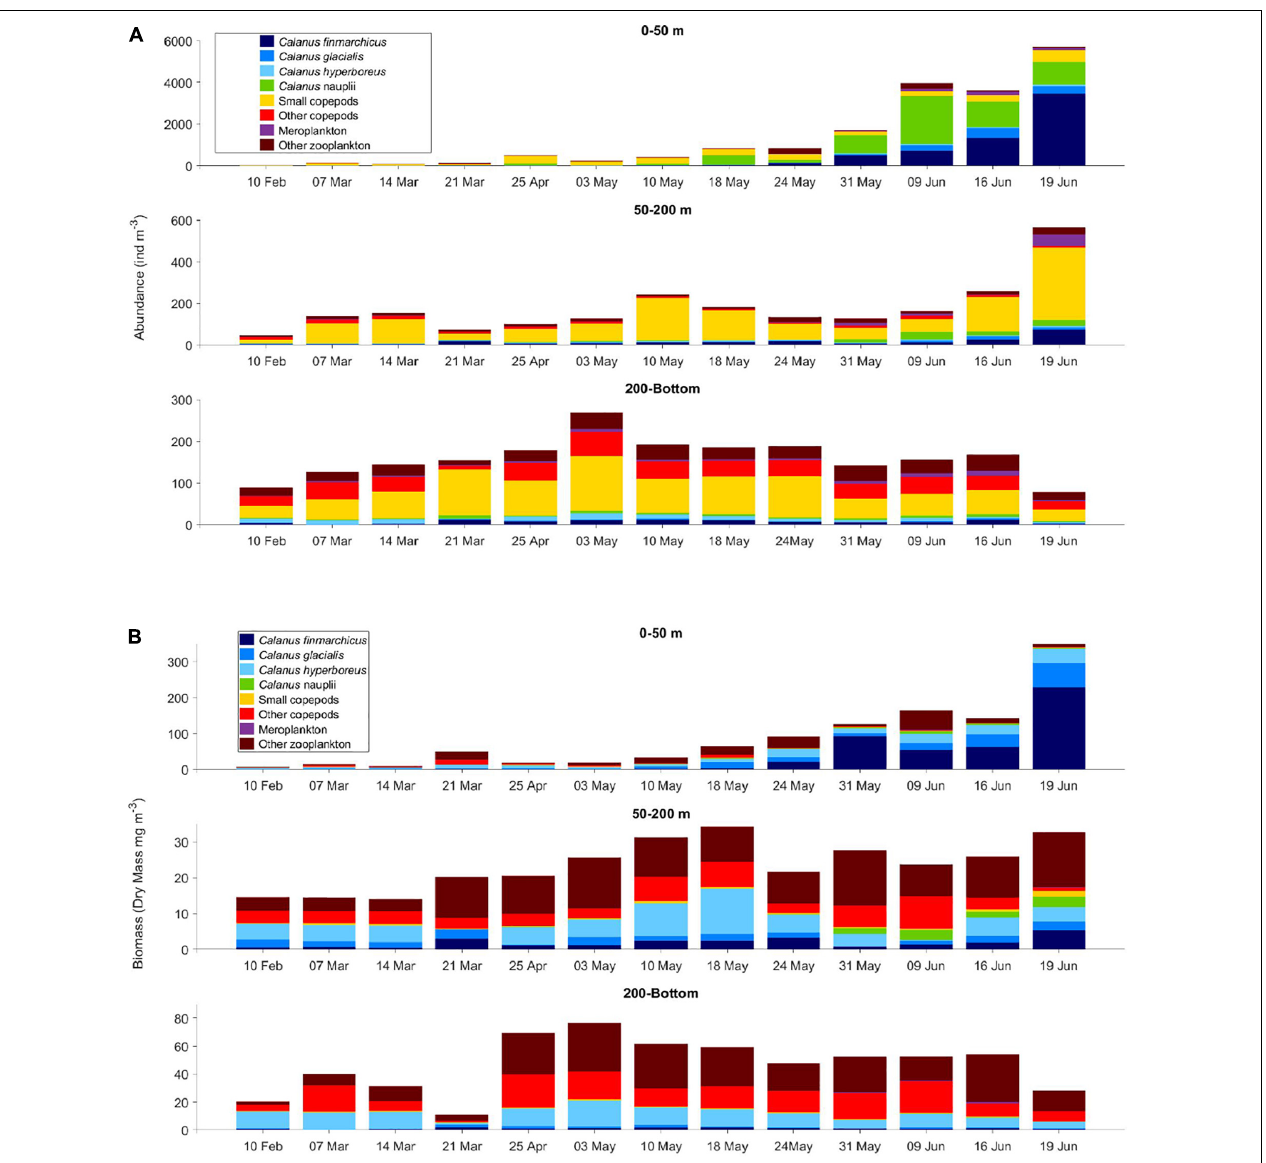
FIGURE 3 | (A) Abundance (ind. m − 3 ) and (B) biomass (dry mass, mg m − 3 ) of main zooplankton taxa sampled with plankton nets (MultiNet and WP-2) in different water layers (depth ranges) from 10 February to 19 June, 2015. Note variations in scale for the different depth layers. The bottom depth on 19 June was 548